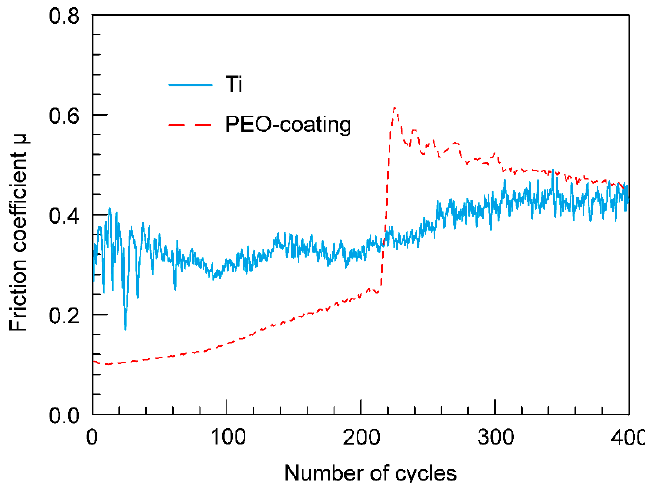
Figure 9. Dependence of the friction coefficient μ on the number of cycles for uncoated sample and sample with a PEO-coating.